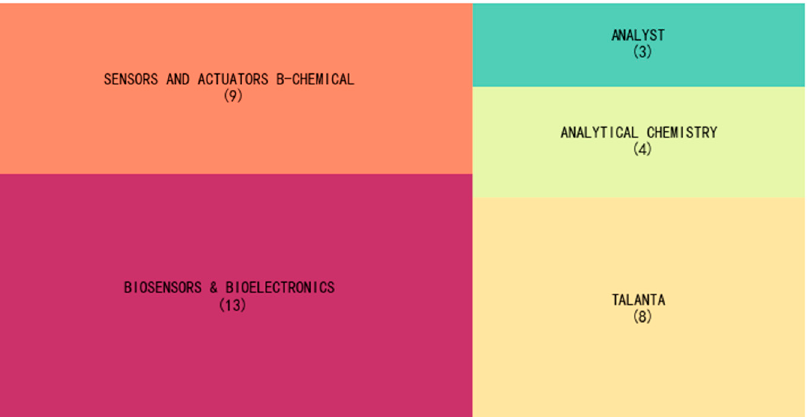
Figure 2. Top 5 journals that published articles on the electrochemical techniques for the detection and analysis of GM crops.